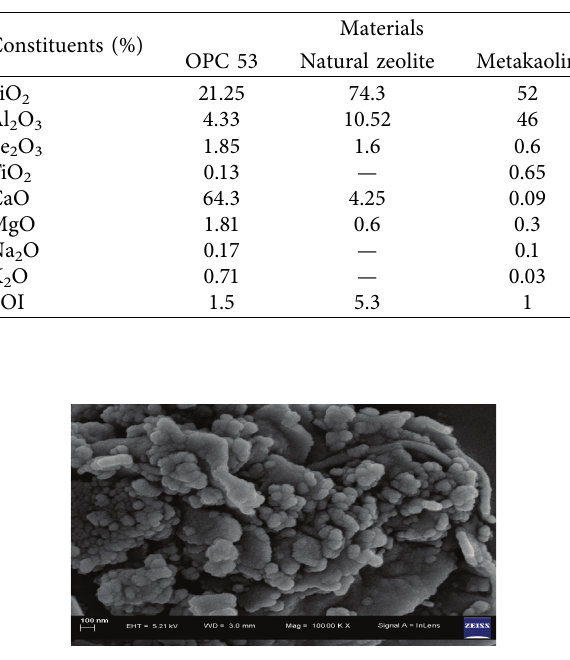
Table 1: The chemical properties of OPC 53 grade cement, natural zeolite, and metakaolin.